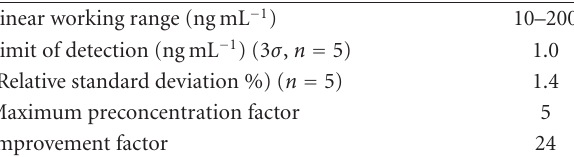
Table 2: Analytical merits of the proposed